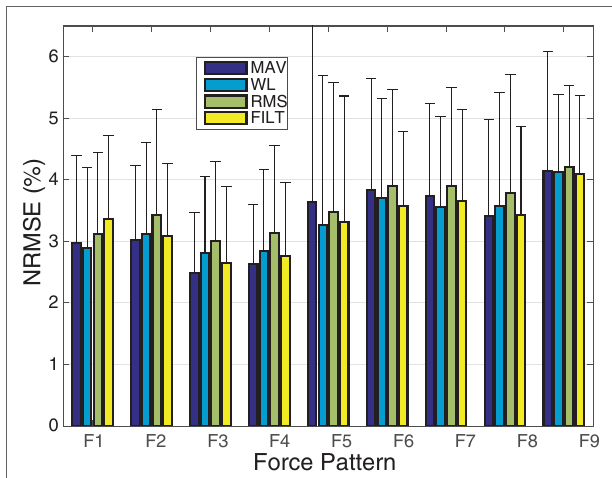
FIGURE 5 | A plot of the average NRMSE for each individual force pattern. The error bars indicate unit SD.